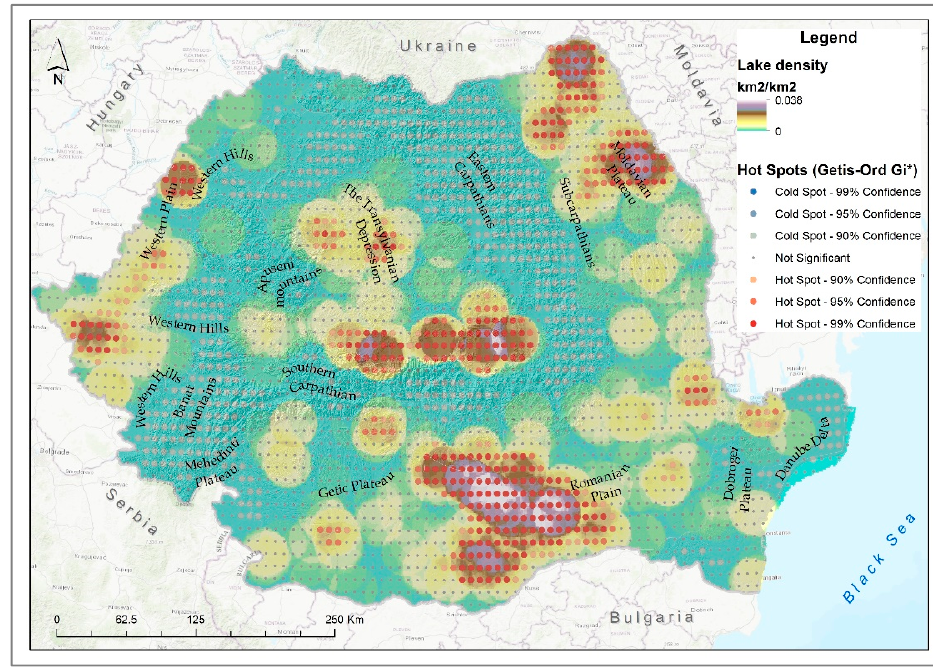
Figure 8. Lake degraded ecosystem density and hotspot analysis.